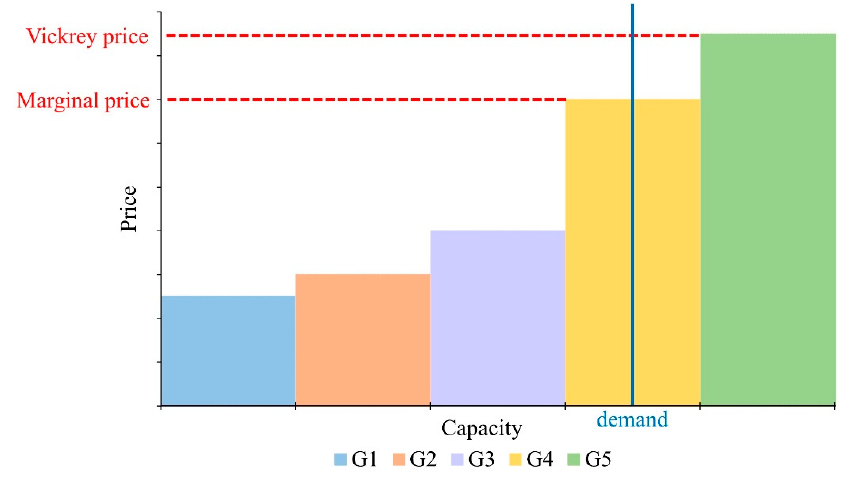
Figure 2. A conceptual diagram for Vickery pricing.